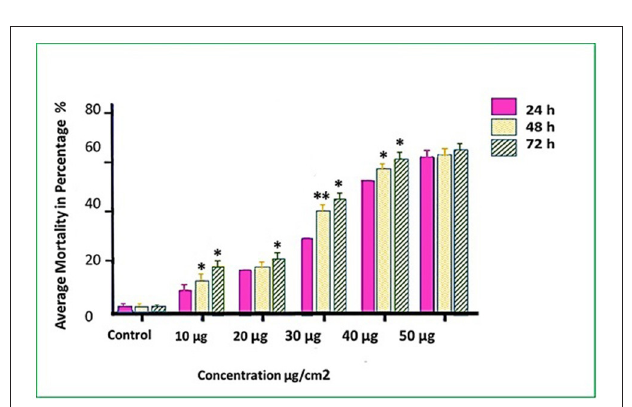
FIGURE 2 | Mortality rates (%) of T. absoluta larvae (late 2nd instars) post feeding access period on v-ATPase B dsRNA-treated leaves. Observed mortality was recorded every 24, 48, and 72h. The average values were obtained over three biological replications. One-way ANOVA followed with Tukey’s multiple comparison ( P < 0.05) were completed. Error bars are the SE ± means-averaged mortality across three trials each with three biological replicates. Asterisk shows statistically significant in various time intervals at different concentrations (* P < 0.05 and ** P <